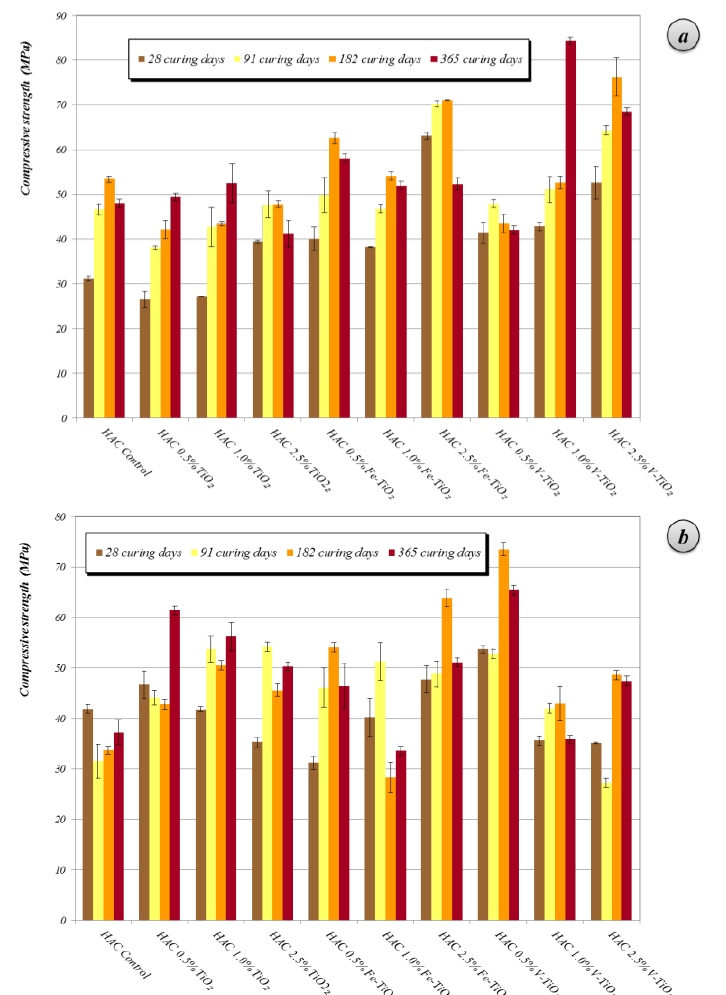
Figure 10. Compressive strengths at different curing times of HAC mortars: ( a ) Curing 20 °C, 95% RH; ( b ) Curing 60 °C, 100% RH, with nano-structured photocatalysts.